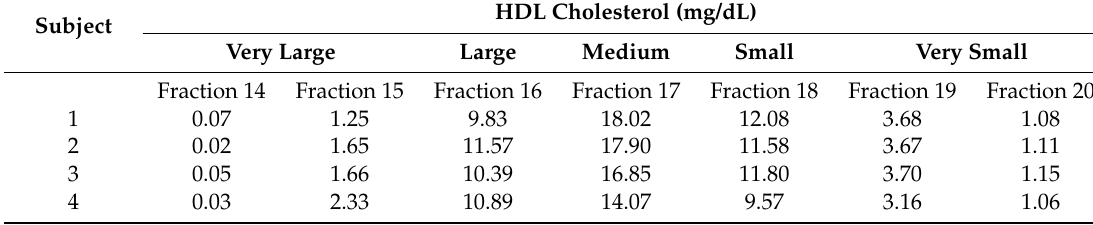
Table 3. The cholesterol concentrations of the subclasses of HDL in four plasma samples containing low or high levels of